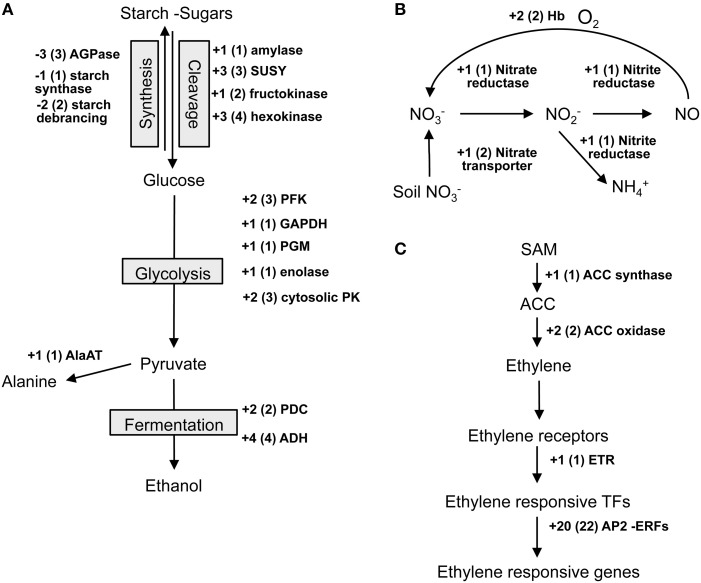
Waterlogging caused differential expression of transcripts encoding proteins involved in energy, nitrate, and ethylene metabolisms. (A) Starch metabolism (Starch), glycolysis, and fermentation (B) Nitrate metabolism (C) Ethylene production and perception. A plus sign represents induction and a minus sign represents reduction. Numbers in brackets represent numbers of DEGs found in this analysis. Data can be found in Supplementary Table S1.